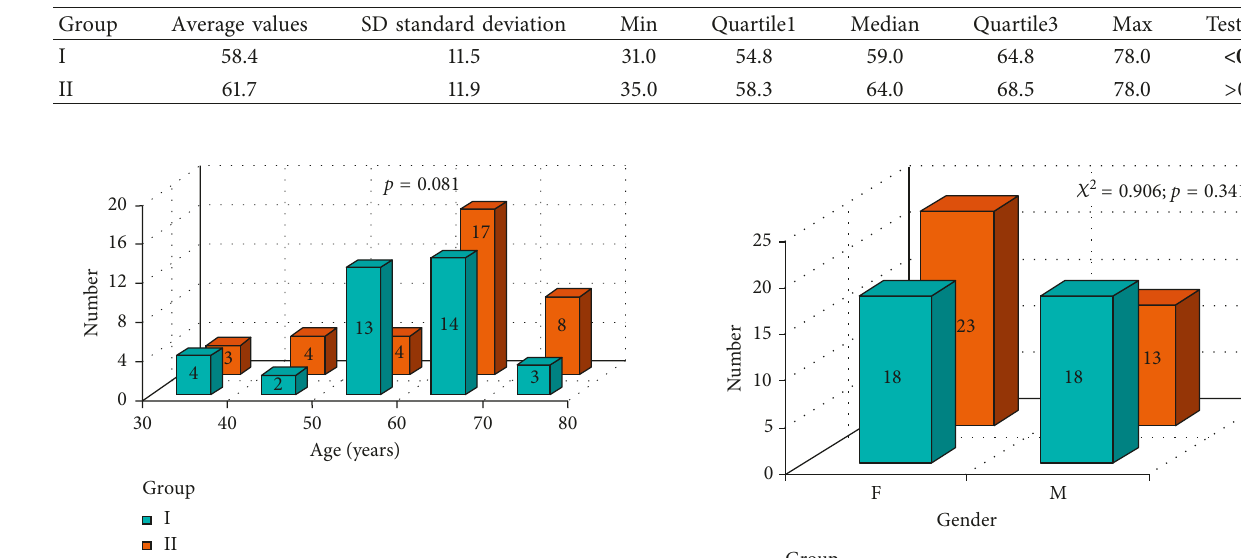
Table 1: Values of basal estimated descriptive parameters for both groups.